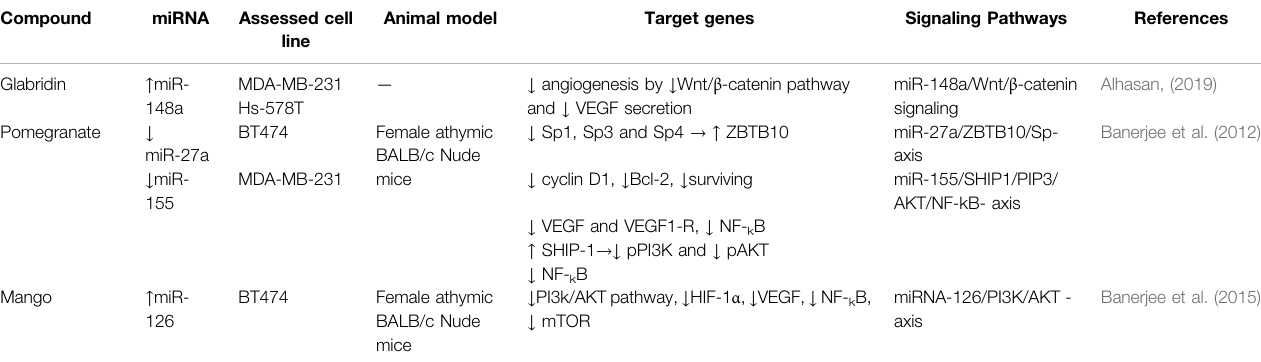
TABLE 3 | ( Continued ) Phytochemicals and their target miRNAs regulating tumor